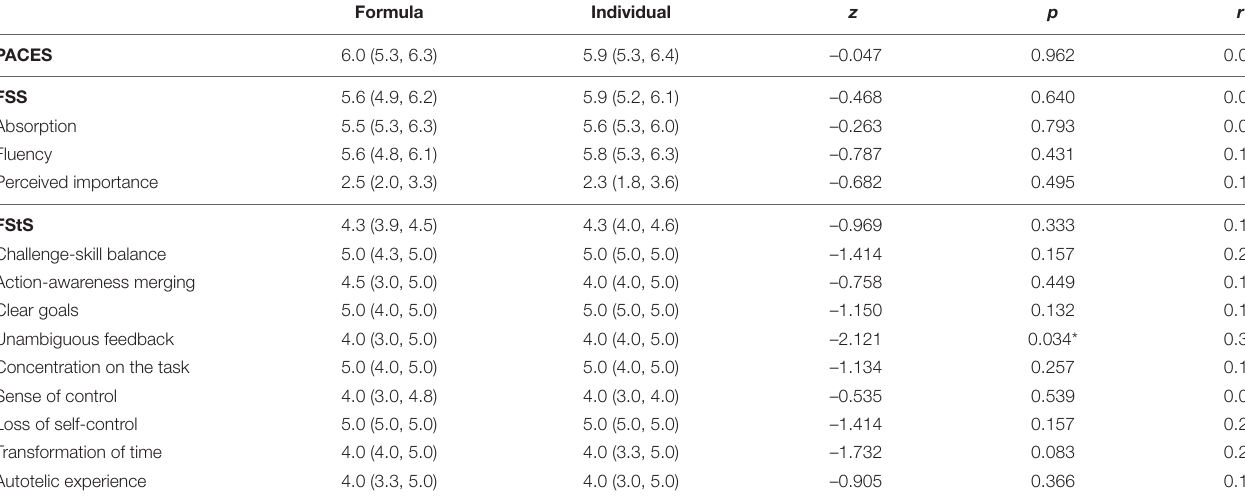
TABLE 4 | Comparison of ExerCube conditions (formula vs. individual) for enjoyment and flow.